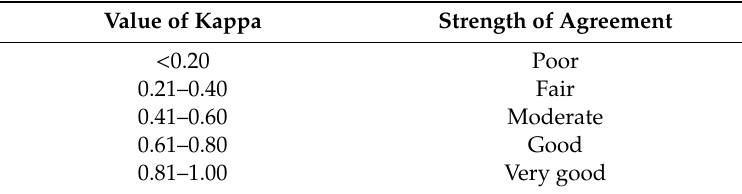
Table 3. Levels of agreement, adapted from Altman [18].